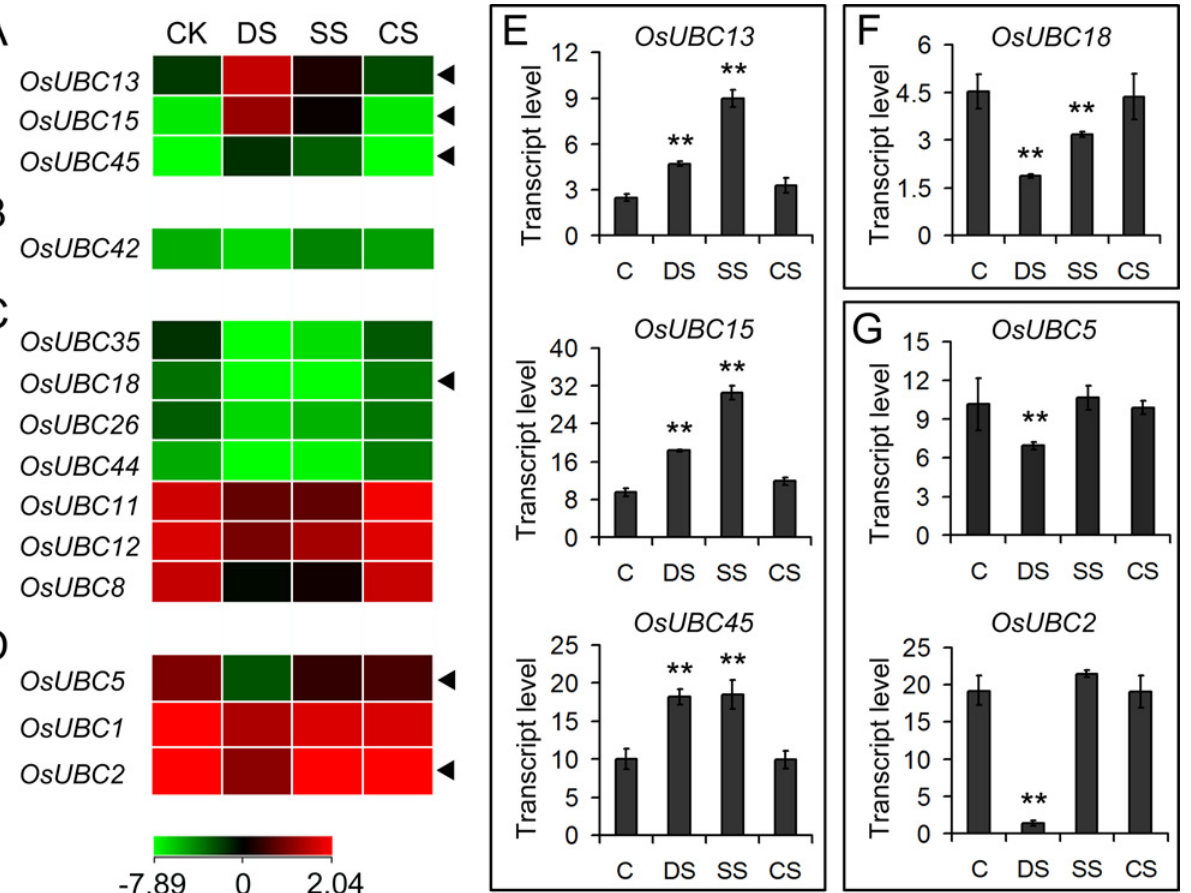
Fig 6. Differential expression profiles of OsUBC genes under abiotic stresses. The microarray data sets (GSE6901) of gene expression under various abiotic stresses were used for cluster display. The average log signal values of OsUBC genes under control and various stress conditions (indicated at the top of each lane) are presented by a heat map. Only those genes that exhibited > 2-fold or more differential expression, under any of the given abiotic stress conditions, are shown. (A) Up-regulated by drought and salt stresses; (B) Up-regulated by salt stress; (C) Down-regulated by drought and salt stresses; (D) Down-regulated by drought stress. The color scale representing average log signal values is shown at the bottom. The representative OsUBC genes differentially expressed under different abiotic stresses for which real-time PCR analysis was performed are indicated by black triangle at the right. The results are shown for confirmation of the differential expression of OsUBC genes up-regulated by drought and salt stresses (E), down-regulated by drought and salt stresses (F), and down-regulated by drought stress (G). Error bars indicate standard deviations of independent biological replicates (n = 3 or more). Two asterisks ( ** , P < 0.01) represent significant differences between the controls and treatments. C, control; DS, drought stress; SS, salt stress; CS, cold